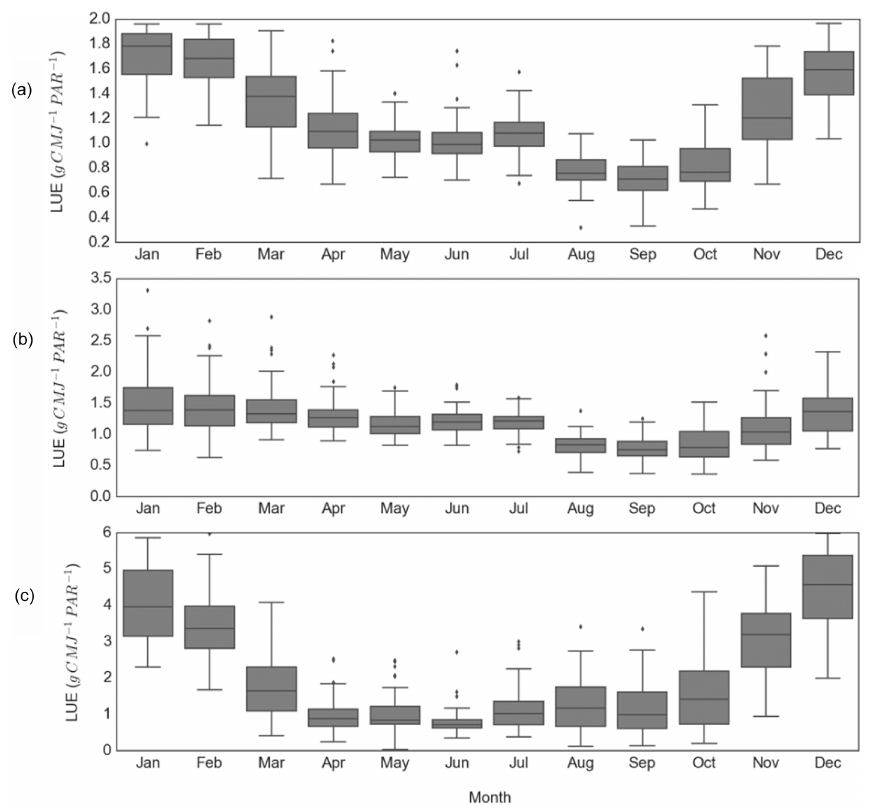
Figure 3. Monthly mean light use efficiency (LUE) ± SE (boxes) with 95% confidence (whiskers) for the Howard Springs OzFlux site ecosystem (a) , overstory (b) and understory (c) from December 2012 to October 2014. Individual dots represent outlier values for each respective